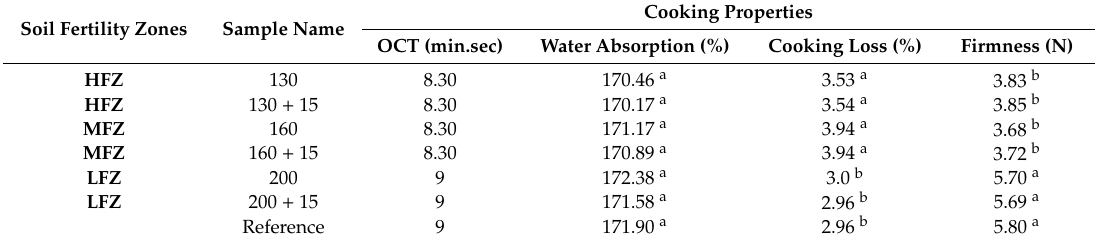
Table 3. Pasta quality parameters (optimal cooking time (OCT), water absorption, cooking loss ( n = 3), and firmness) of pasta from site-specific harvest of cv. Biensur compared with those of the commercial reference cv.